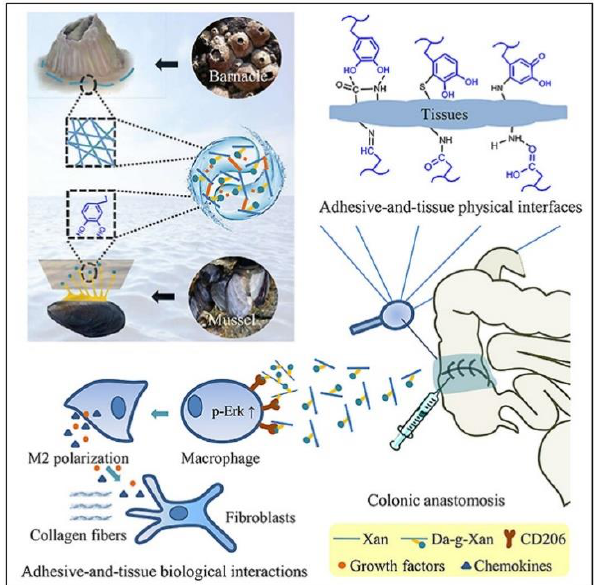
Figure 6. Background on the marine-inspired immunogenic hydrogel adhesive [100], reprinted with permission from science direct under CC BY-NC-ND 4.0.